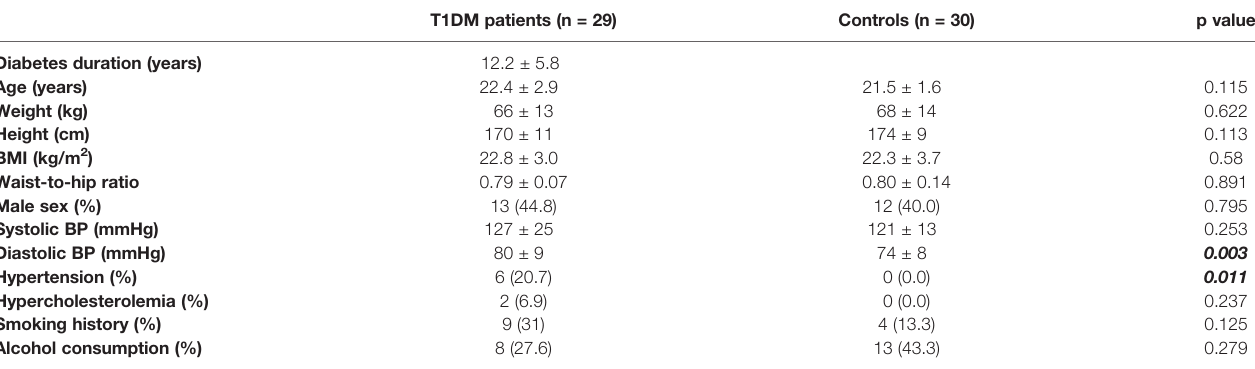
TABLE 1 | Clinical data in the study